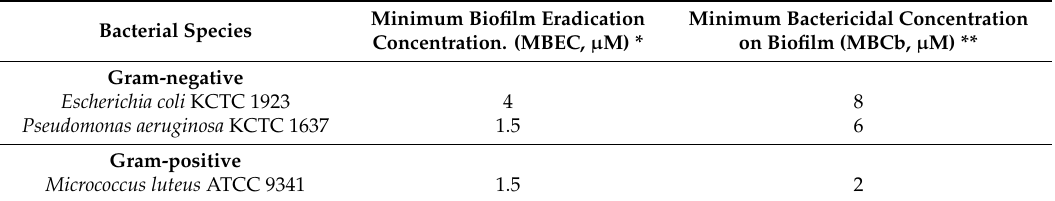
Table 4. Antibiofilm activity table of MS07 with various bacterial